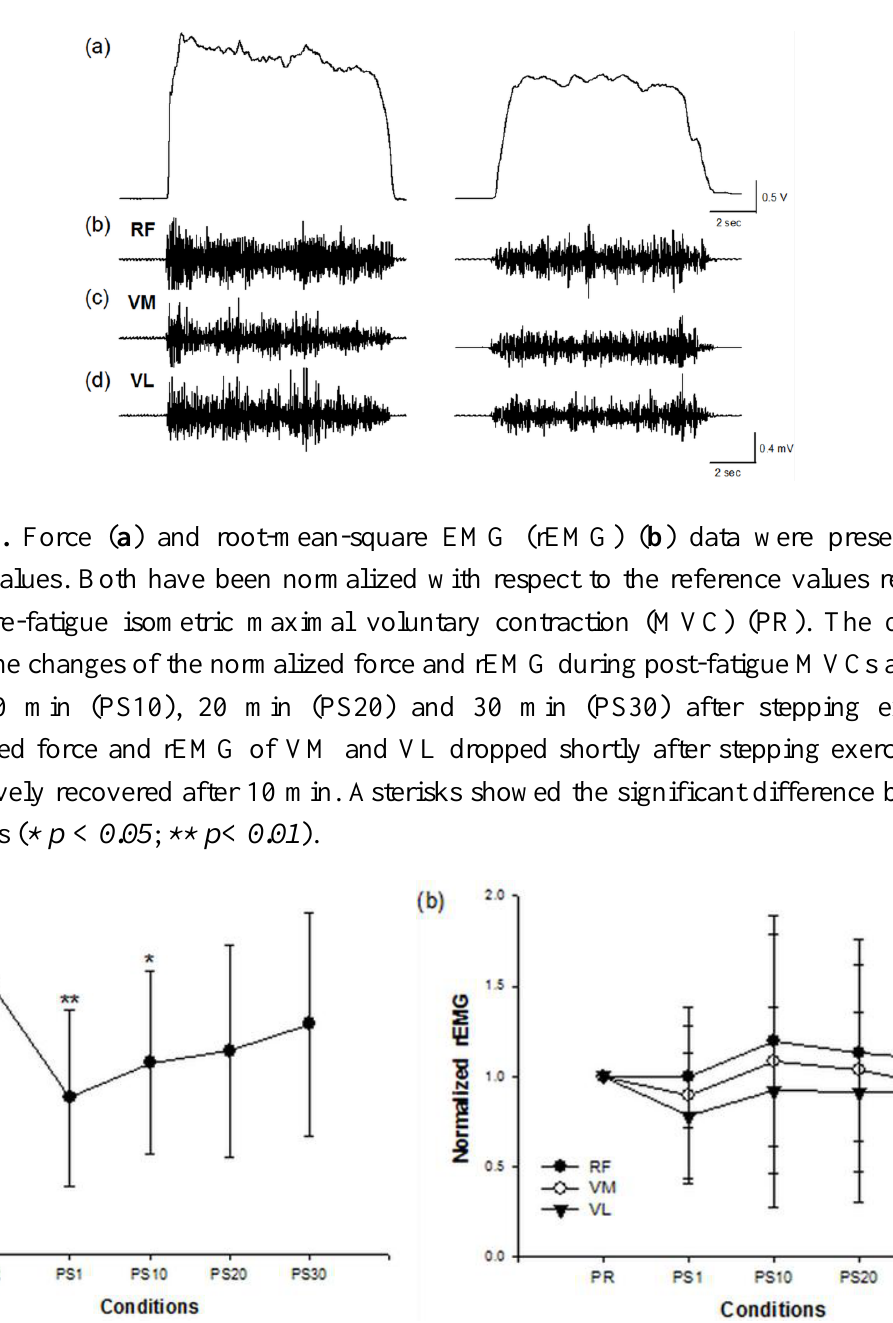
Figure 1. A single trial data of a representative subject during 10-sec isometric MVCs before (left column) and 1 min after (right column) the stepping exercise. ( a ) Force of knee extensors ( b ) electromyogram (EMG) of rectus femoris (RF) ( c ) EMG of vastus medialis (VM) ( c ) EMG vastus lateralis (VL).